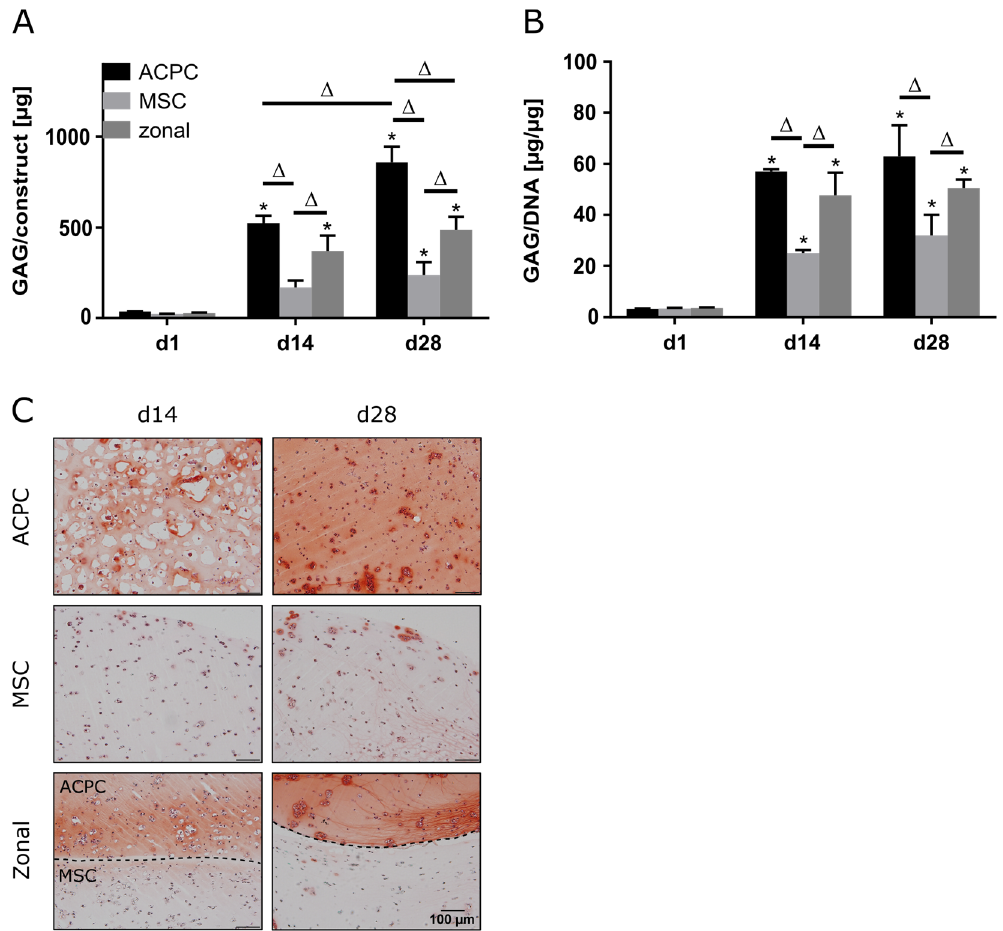
Figure 3. GAG production in ACPC, MSC, and zonal constructs under hypoxic conditions. Biochemical and histological analysis of GAG in agarose hydrogel constructs, seeded with 20.0 × 10 6 cells mL − 1 , after 1, 14, and 28 days of chondrogenic di ff erentiation under hypoxic conditions. ACPCs and MSCs were either cultured alone or in zonally layered co-culture constructs. ( A ) Production of total GAG (GAG / construct) and ( B ) GAG normalized to DNA (GAG / DNA). Data are presented as means ± standard deviations ( n = 3 biological replicates). Note: (*) indicates statistically significant di ff erences between a d14 or d28 value and the corresponding d1 value of the same group ( p < 0.05); ( ∆ ) indicates statistically significant di ff erences between groups, or within a group between time points ( p < 0.05). ( C ) Histological safranin-O staining for visualization of GAG produced under hypoxic conditions. In zonal constructs, the upper layer contained ACPCs and the lower layer contained MSCs (indicated by the dashed